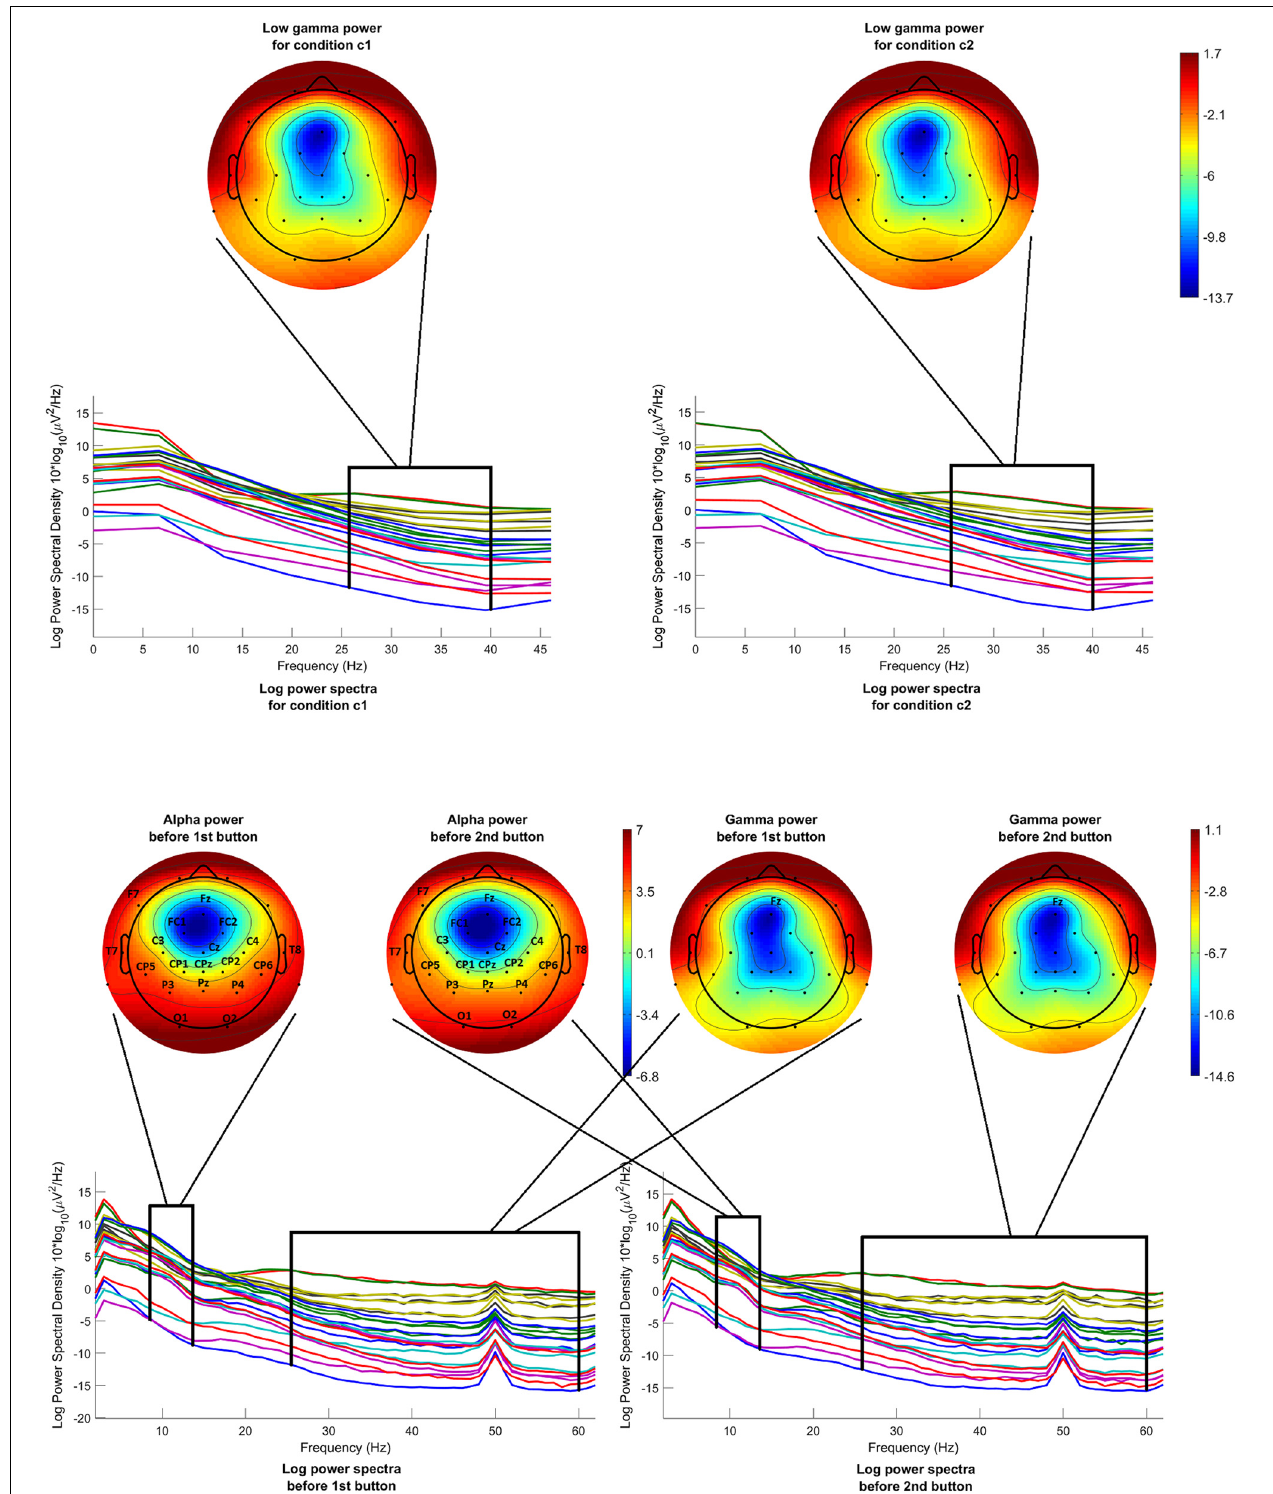
FIGURE 5 | Mean log power spectra over all participants, in the interval [–200 –50]ms before onset, for each channel and for both conditions and respective scalp maps after averaging over the low gamma band (26–40 Hz) (above). Mean log power spectra over all participants, in the interval [–1000 0]ms before 1st and 2nd button, for each channel and respective scalp maps after averaging over the alpha band (8–13 Hz) ( on the left ) and over the gamma band (26–60 Hz) ( on the right ). The labels of the channels indicate the locations where the difference passed the threshold.